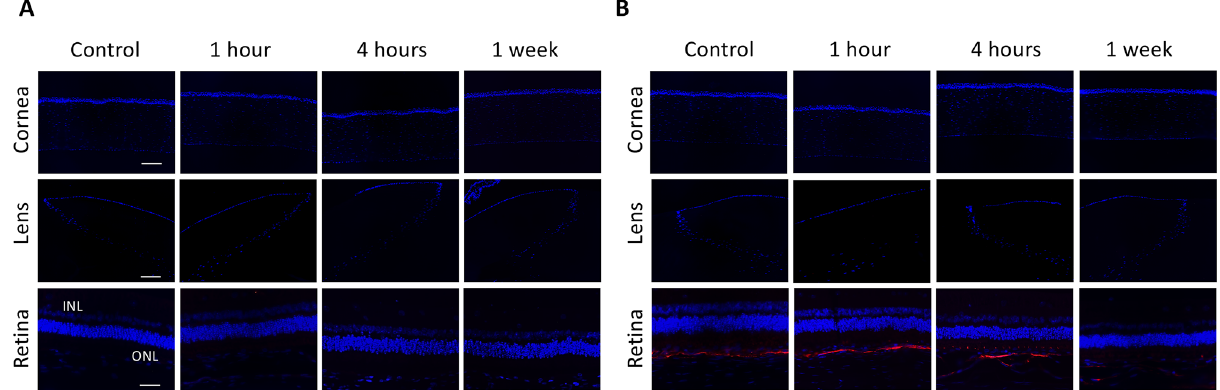
Figure 8. Immunohistochemical analysis on fibronectin showed negative staining in corneas, lens epithelium and retinas at all time points ( A ). Staining for α-SMA was present at Bruch’s membrane and sclera with a comparable extent in all eyes ( B ). IPL: inner plexiform layer; ONL: outer nuclear layer. Nuclei were counterstained with DAPI (blue). Scale bar 100 μm.